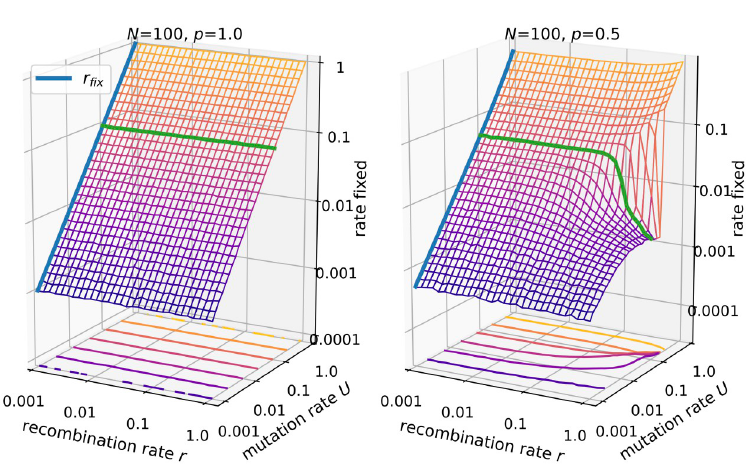
Fig 3. Fixation rate of segregating mutations in the ism . Parameters are N = 100 and p = 1.0 (left panel) vs. p = 0.5 (right panel). The green line is drawn at U = 0.1. The blue line represents Eq